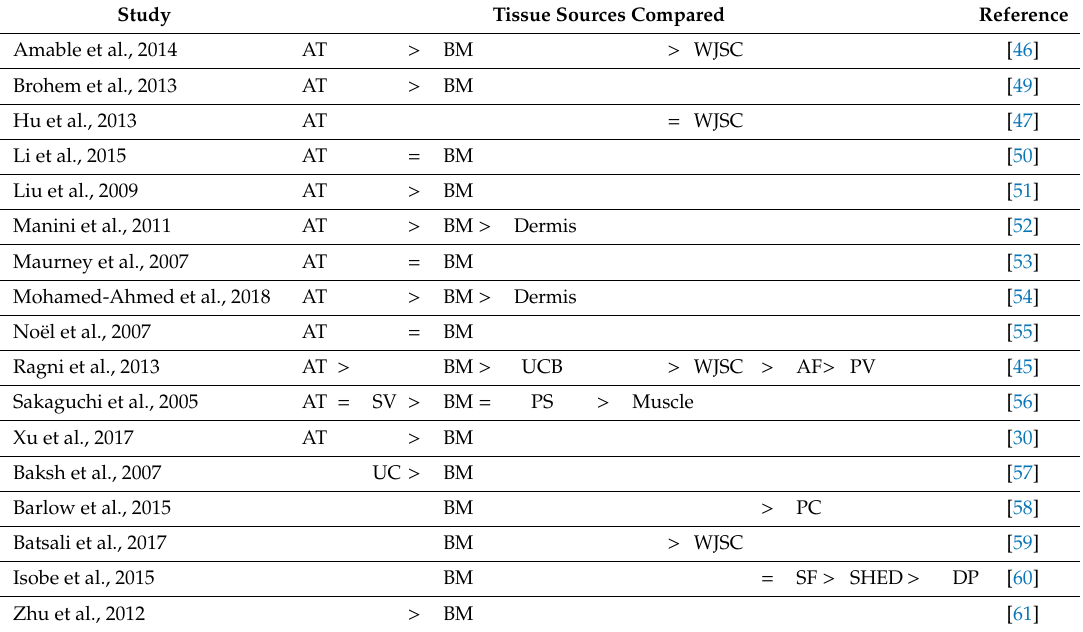
BM > BM AF, amniotic fluid; AT, adipose tissue; BM, bone marrow; DP, dental pulp; nFS, neonatal foreskin; SHED, exfoliated deciduous teeth; PS, periosteum; PV, perivascular region of UC; SF, synovium fluid; SV, synovium; PC, placenta; UCB, umbilical cord blood; UC, umbilical cord; = , no di ff erence in adipogenic potential was